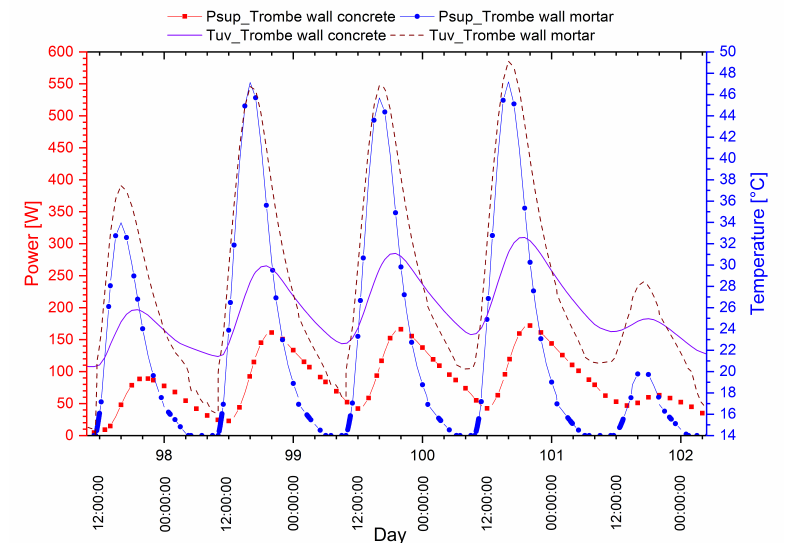
Figure 9. Comparison of the power supplied and air temperature at the upper vent of the ventilated air gap over four sunny days (from Day 98 to Day